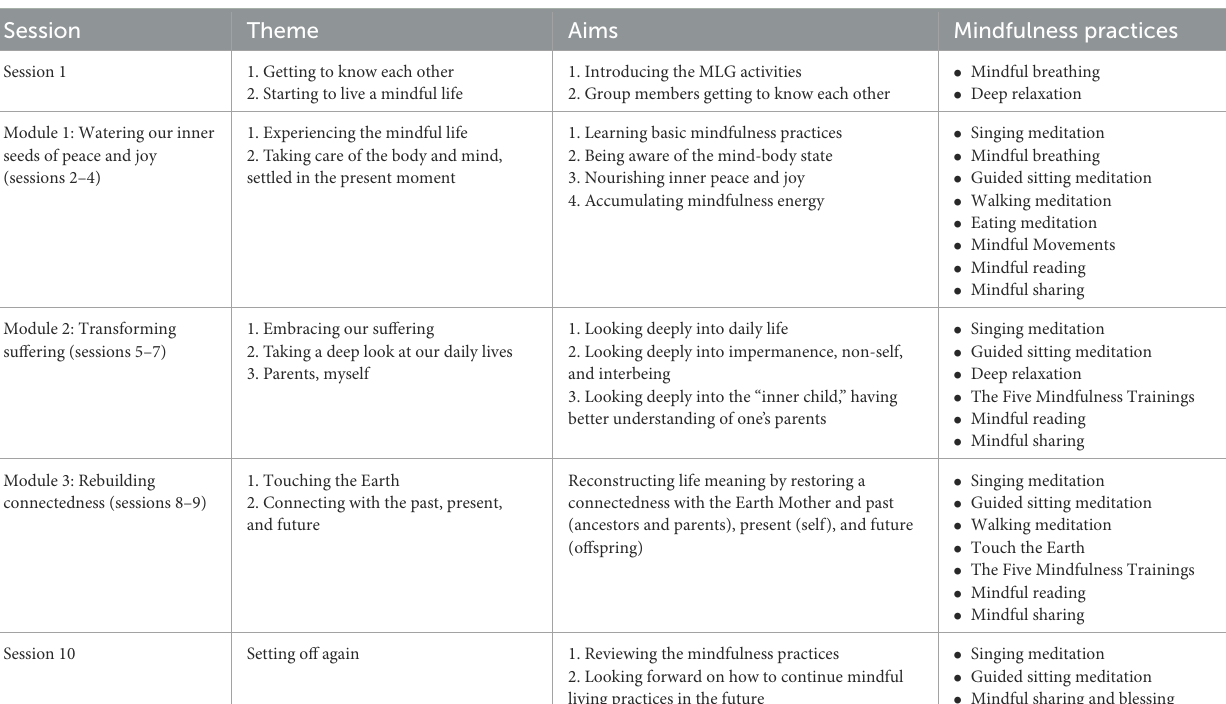
TABLE 1 The MLG manual framework of